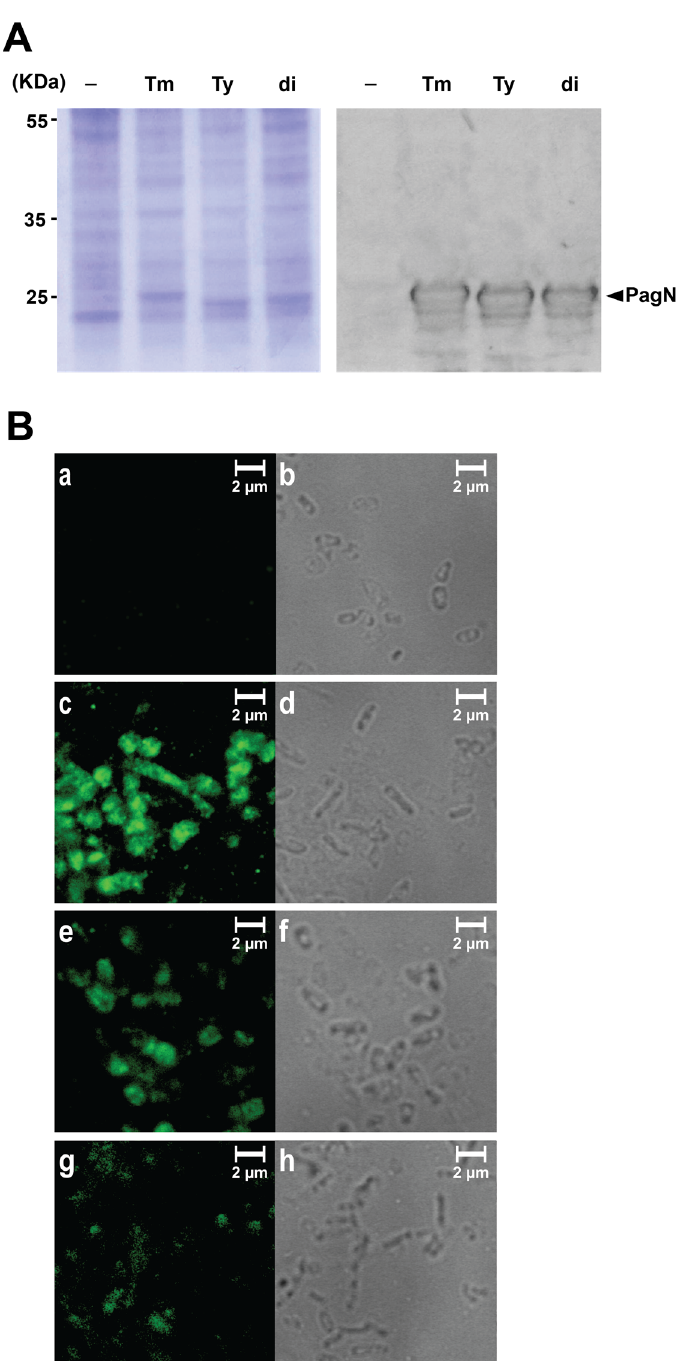
Figure 2. Expression of pagN alleles from S. Typhimurium, S. Typhi and S. diarizonae . ( A ) Expression of PagN in E. coli AAEC189 transformed with pRS1 (empty vector, -), pDMS1973 ( pagN Ty ), pDMS1974 ( pagN Tm ) or pDMS2062 ( pagN di ) was induced by AHT (0.2–0.4 µg/mL) for 2 h at 37 ℃ . Isolated outer membrane proteins analyzed by SDS-PAGE, followed by Coomassie blue staining or western blotting with anti-PagN antisera showed a clear band for PagN expression at 25 kDa. ( B ) Visualization of PagN surface expression in E. coli AAEC189 expressing the allele from S. Typhimurium (c and d), S. Typhi (e and f), S. diarizonae (g and h) or empty vector as negative control (a and b). Phase-contrast microscopy (right) and fluorescence microscopy (left) were used to detect bacteria labeled with anti-PagN antisera, followed by Alexa Fluor 488-conjugated anti-rabbit IgG. Moreover, both alleles of PagN were detectable on the bacterial surface by immunofluorescence (Figure 2B, panel a to f) and ELISA (not shown). Not surprisingly, the strongest signal was observed for the S. Typhimurium PagN allele, as this was the immunogen used to prepare the antiserum.